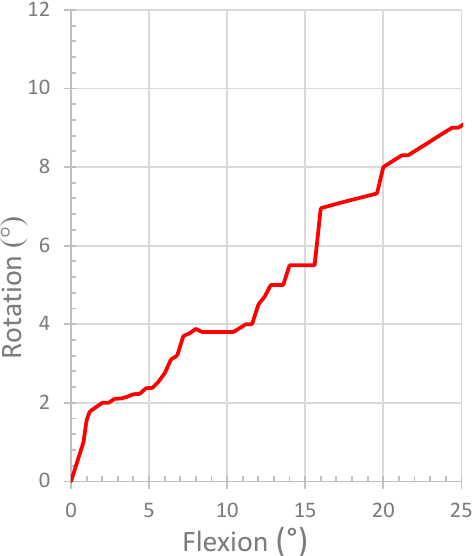
Figure 10. A Graph of Rotation Against Flexion at the position of 25°.